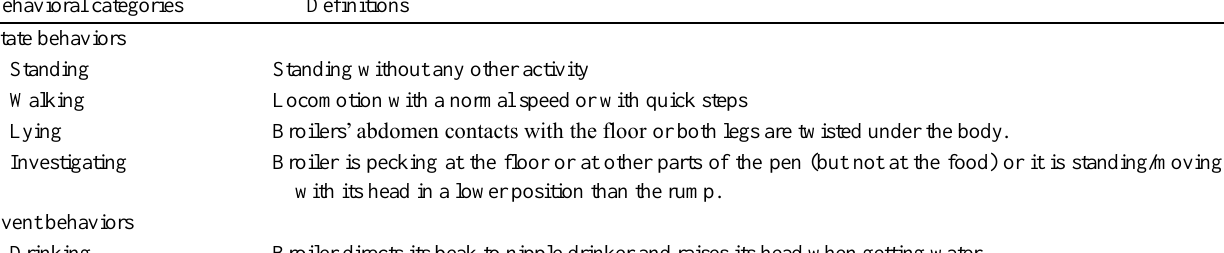
Table 1. Behavioural categories and the definitions Behavioral categories